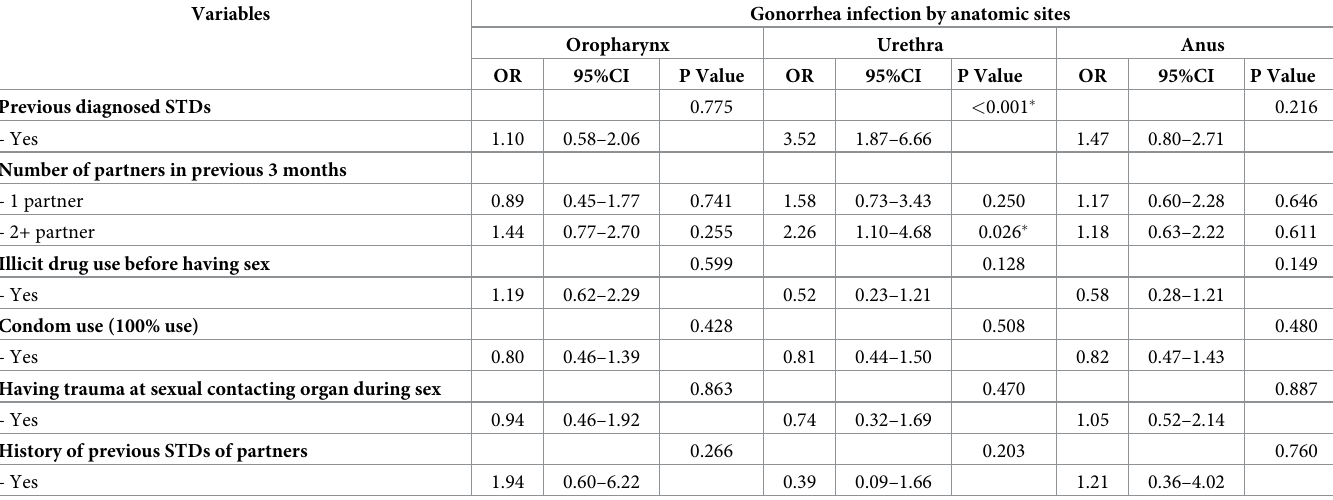
Table 4. Adjusted odds ratio for each selected factors associated with gonorrhea by anatomic distributions using multivariate analysis.